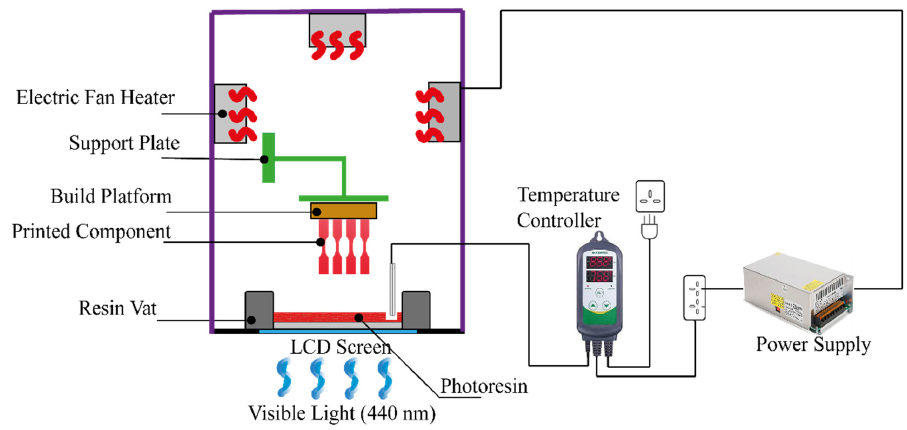
Figure 2. A schematic of the hot lithography setup used in this